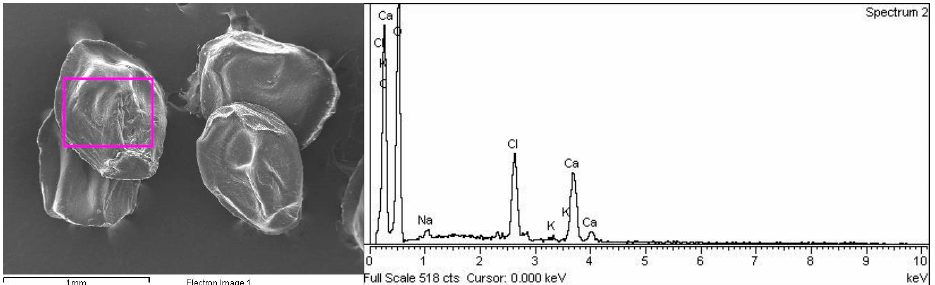
Figure 4. Morphology and surface elemental analysis using EDS (expressed in the atomic weight percent) of Alg/Z/HPMC microparticles loaded with rosemary extract. Bar is indicated.